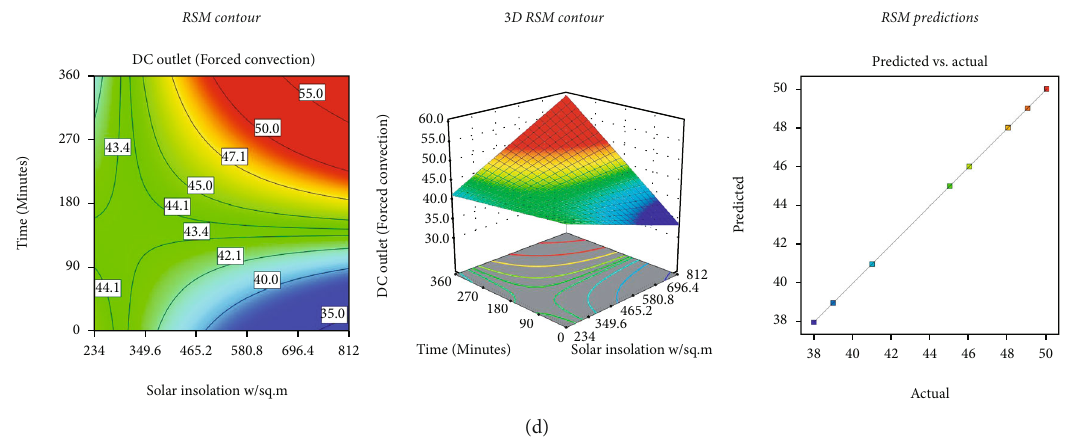
Figure 5: Variation of temperature in drying chamber in natural and forced convection using